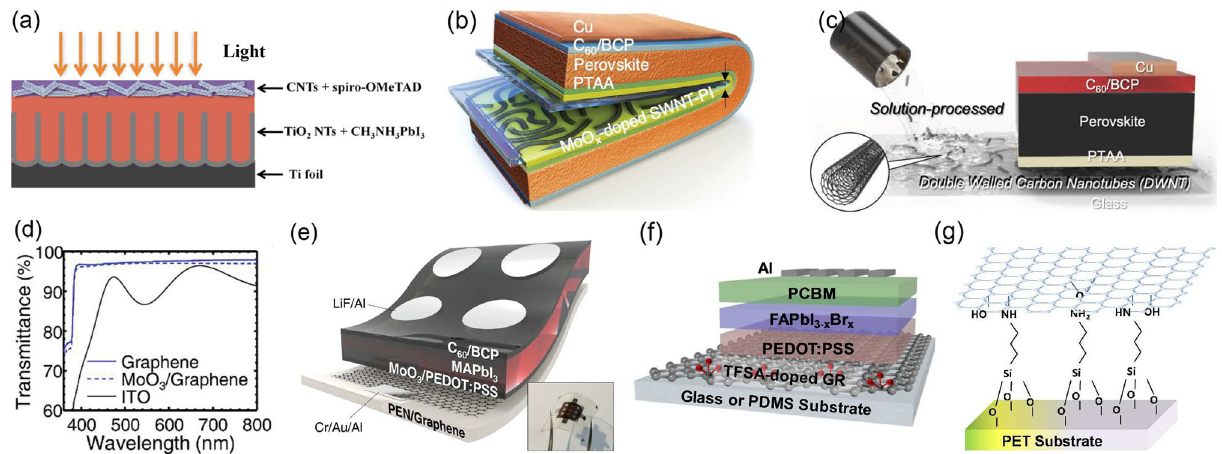
Fig. 3 a Schematic device structure of FPSCs based on CNTs top electrode. Reproduced with permission from Ref. [78]. Copyright 2015, Elsevier. b Foldable PSCs employing SWNTs-embedded PI substrate. Reproduced with permission from Ref. [91]. Licensed under a Creative Commons Attribution (CC BY) license. c Schematic illustration of PSC structure using solution-processed DWNTs as transparent electrode. Reproduced with permission from Ref. [92]. Copyright 2019, John Wiley and Sons. d Transmittance spectra of graphene/PEN, MoO 3 /graphene/ PEN, and ITO/PEN substrates. e Device structure of FPSCs based on MoO 3 doped graphene electrode (The inset image is the picture of full device). d , e Reproduced with permission from Ref. [96]. Copyright 2017, Royal Society of Chemistry. f Device schematic of FPSCs with TFSA doped graphene as electrode. Reproduced with permission from Ref. [77]. Copyright 2018, Royal Society of Chemistry. g The covalent bonding between PET and graphene layer with APTES interlayer. Reproduced with permission from Ref. [102]. Copyright 2017, Royal Society of Chem-